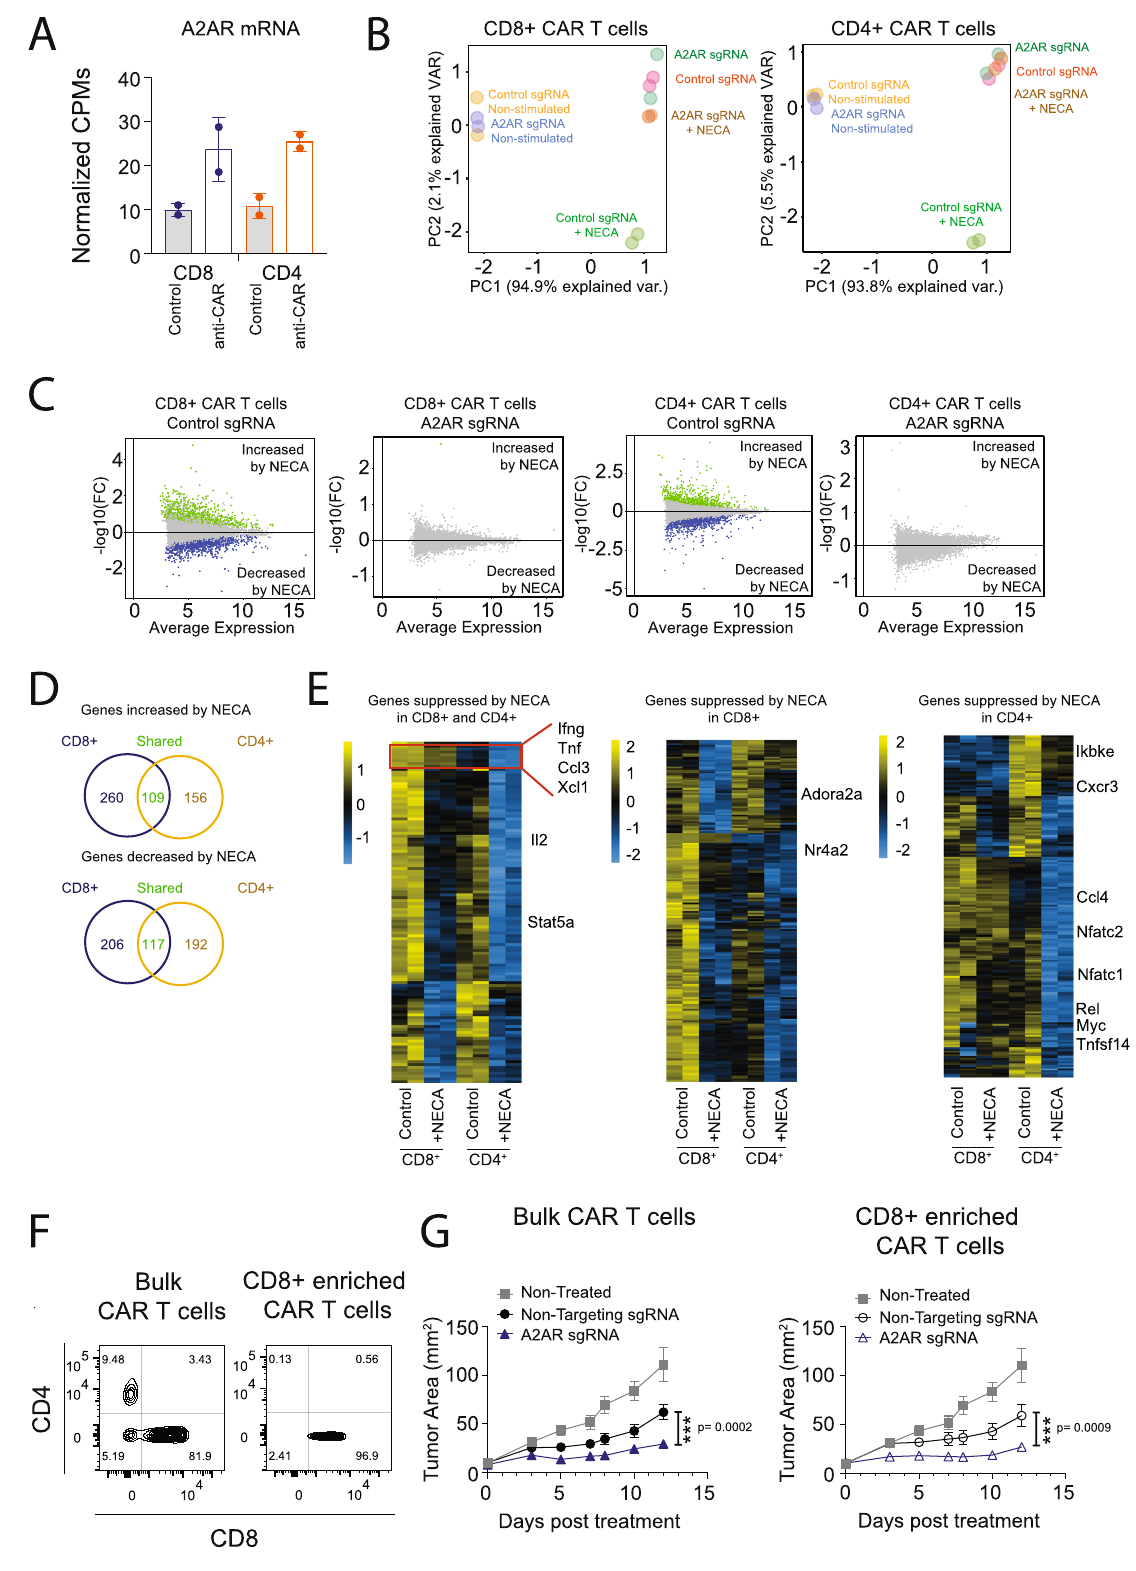
editing at the only three predicted off- target sites (Supplemen- tary Fig. 7A – C). Similarly to previous studies using human CAR T cells targeting Her2, mesothelin, or CD19 16,43,44 , the produc- tion of IFN γ and TNF by anti-Lewis Y CAR T cells was sig- ni fi cantly suppressed by NECA during coculture with Lewis Y + OVCAR-3 tumor cells, an effect that was reversible through